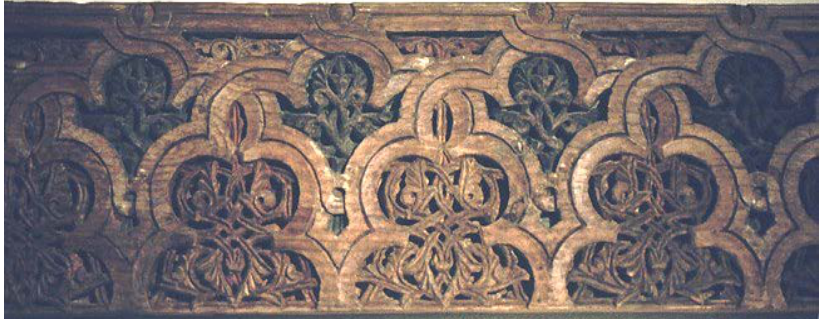
Figure 3.One of collections of Islamic art , Paris